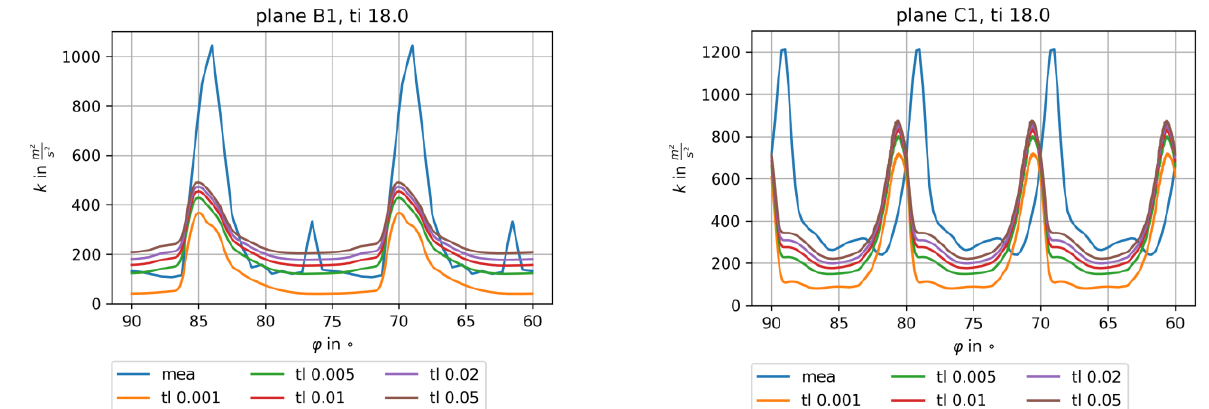
Figure 5. Comparison of turbulence kinetic energy in planes B1 ( left ) and C1 ( right ) for an inlet turbulence intensity of 18% and varying turbulence length scale (1–50 mm) (mea … measured) (Q3D simulation at mid-section).